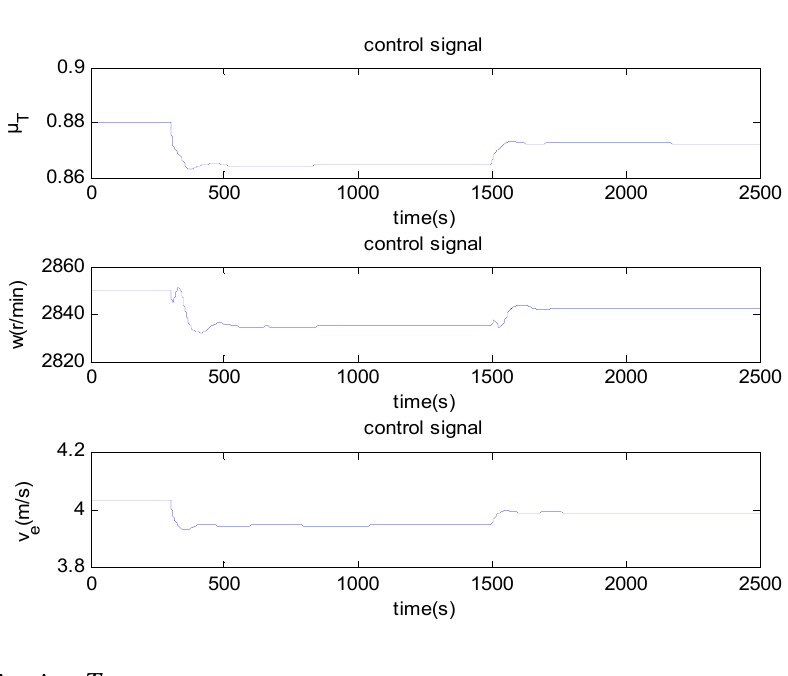
Figure 8. Responses of manipulated